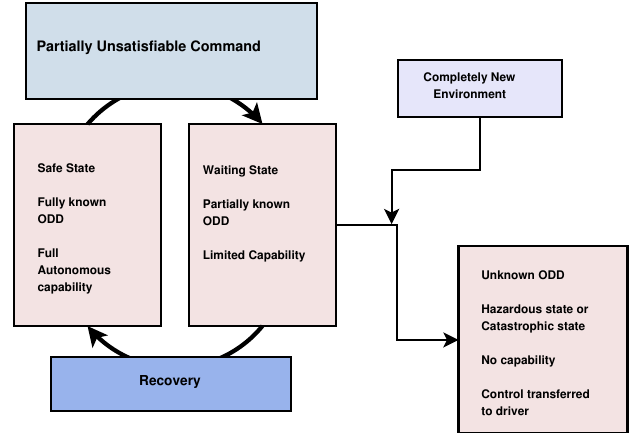
Figure 1. Operational states of